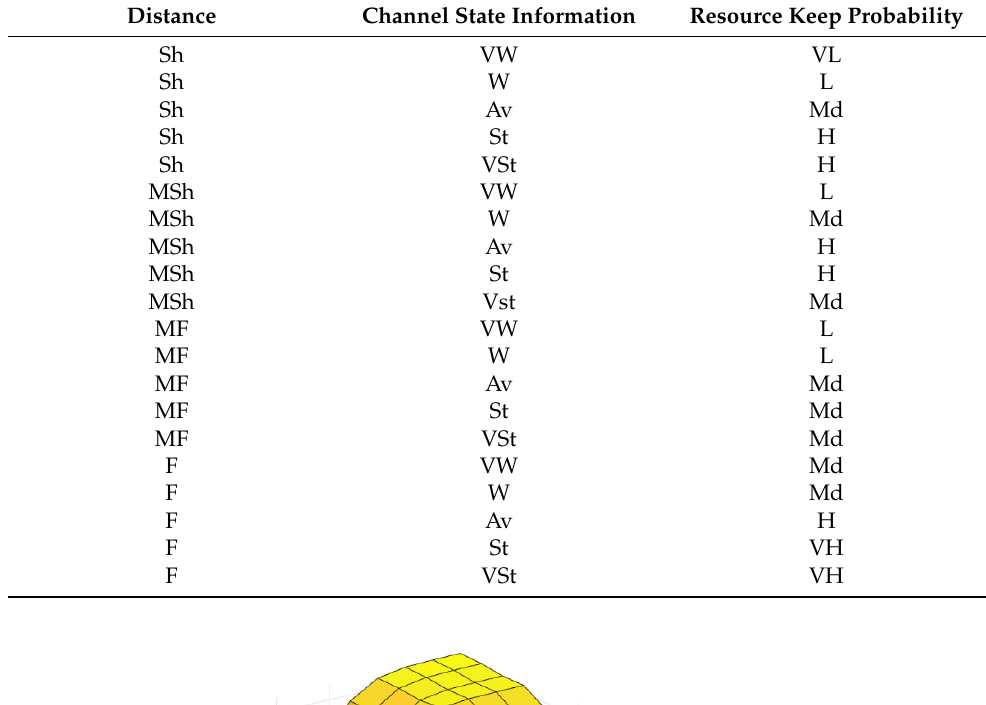
Table 1. The rule bases for the proposed FIS.